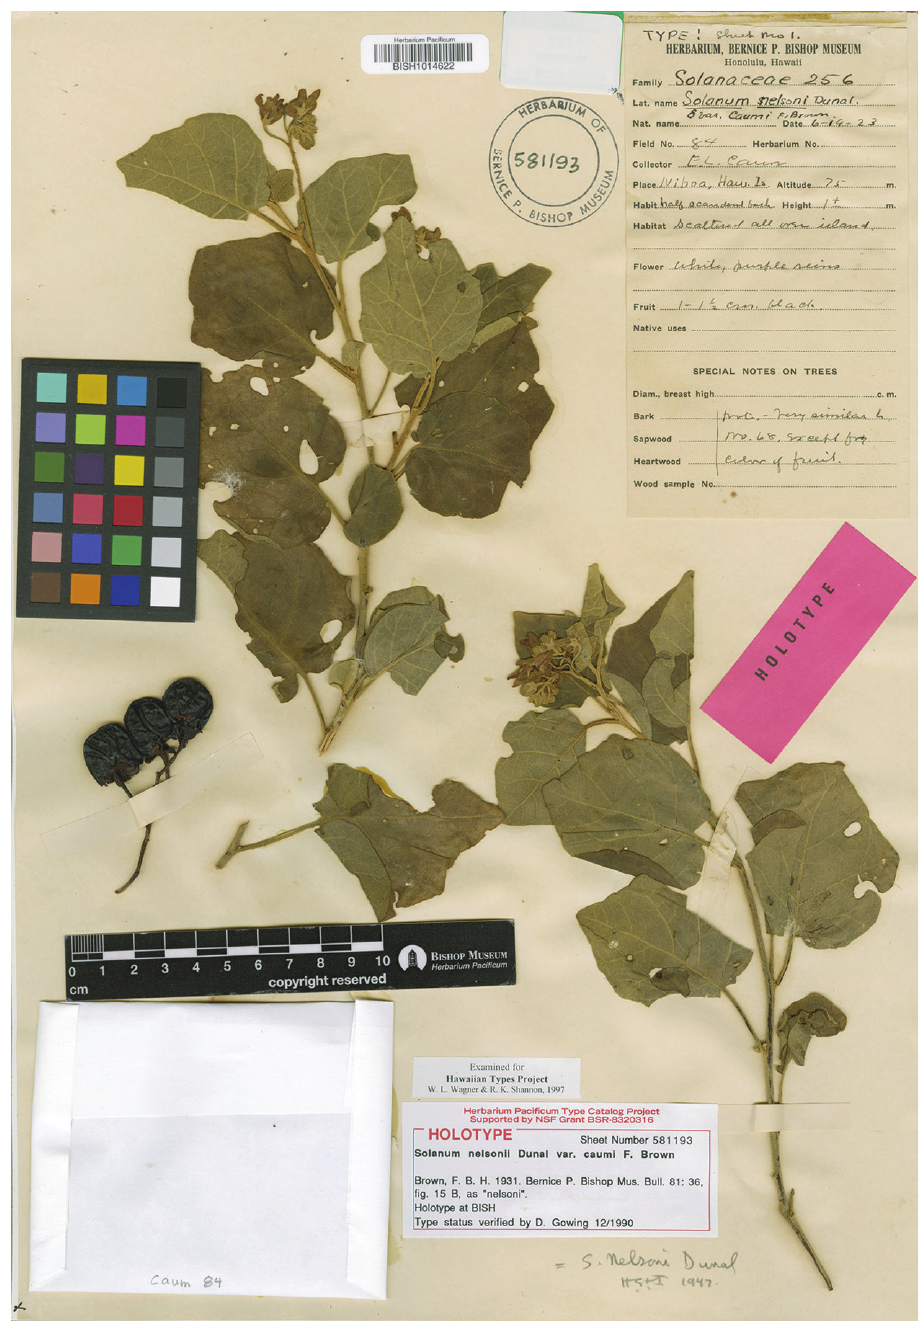
Figure 4. Solanum caumii (F.Br.) D.McClelland (holotype of S. nelsonii var. caumii F.Br., E. Caum 84 BISH [acc. # 581193, barcode BISH1014622]). Reproduced with